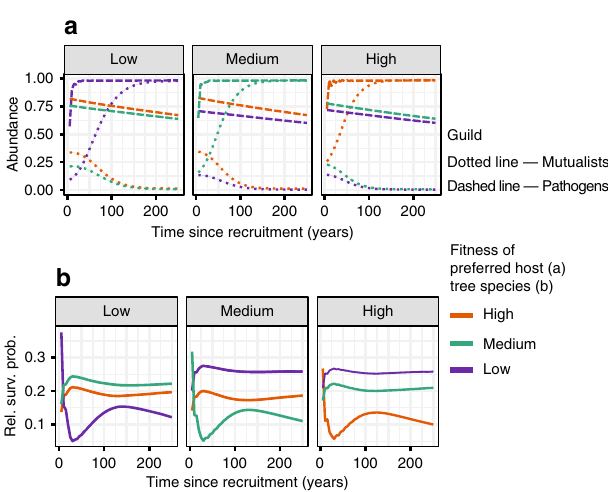
Fig. 3 Temporal results after 3 K time steps for fi ve-species simulation. Results are illustrated for three species representing the most fi t, least fi t, and intermediate species (high, low, and medium fi tness, respectively). a Mean abundances of pathogens and mutualists over time on each of the three host species. In all panels time = 0 represents the time at which the adult species occupying the focal cell changes to the species listed at the top of each panel. Each line represents the average population dynamics of the three mutualist and pathogen species as the focal plant increases in age. b Mean survival probabilities over time of each plant species in cells occupied by different species of adults. Each cut-out represents the average temporal dynamics of survival probabilities beneath one of the three focal adult species. Shaded bands in panels ( a ) and ( b ) cover the mean ± s.e.m., where n = 48 independent simulation runs. Although standard error values are displayed, values are too small to be visible. a Pathogens rapidly increase in abundance on their preferred hosts, but non-speci fi c pathogens maintain high abundances as well. Conversely, mutualists increase more slowly than pathogens on their preferred host, and drive non-speci fi c mutualists to low abundances. b After a new species recruits in a given cell, the survival probability of its seedlings rapidly decreases as its pathogen increases in abundance. Its survival probability subsequently increases with the abundance of its preferred